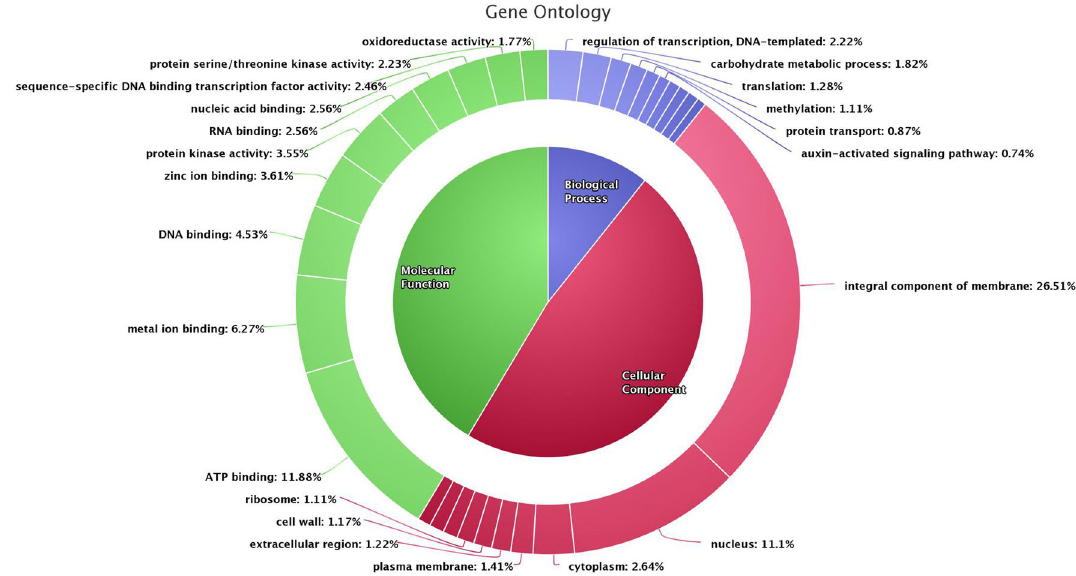
Figure 1. Gene ontology chart of Vigna mungo